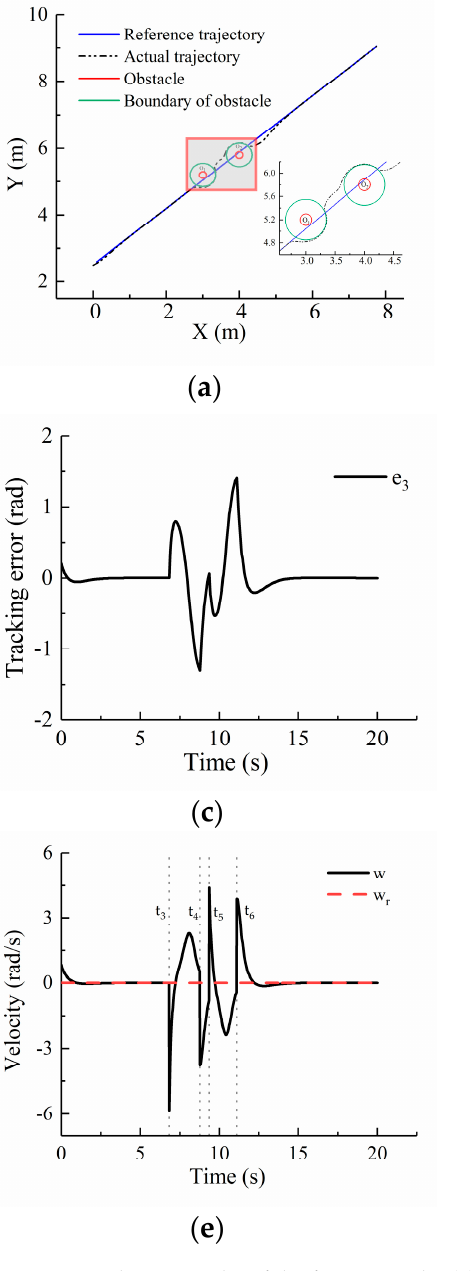
Figure 5. Simulation results of the first example: ( a ) Trajectory tracking and obstacle avoidance results; ( b ) position tracking error; ( c ) angular tracking error; ( d ) control input v and reference velocity v r ; ( e ) control input ω and reference velocity ω r ; ( f ) relative distances between the robot and obstacles.